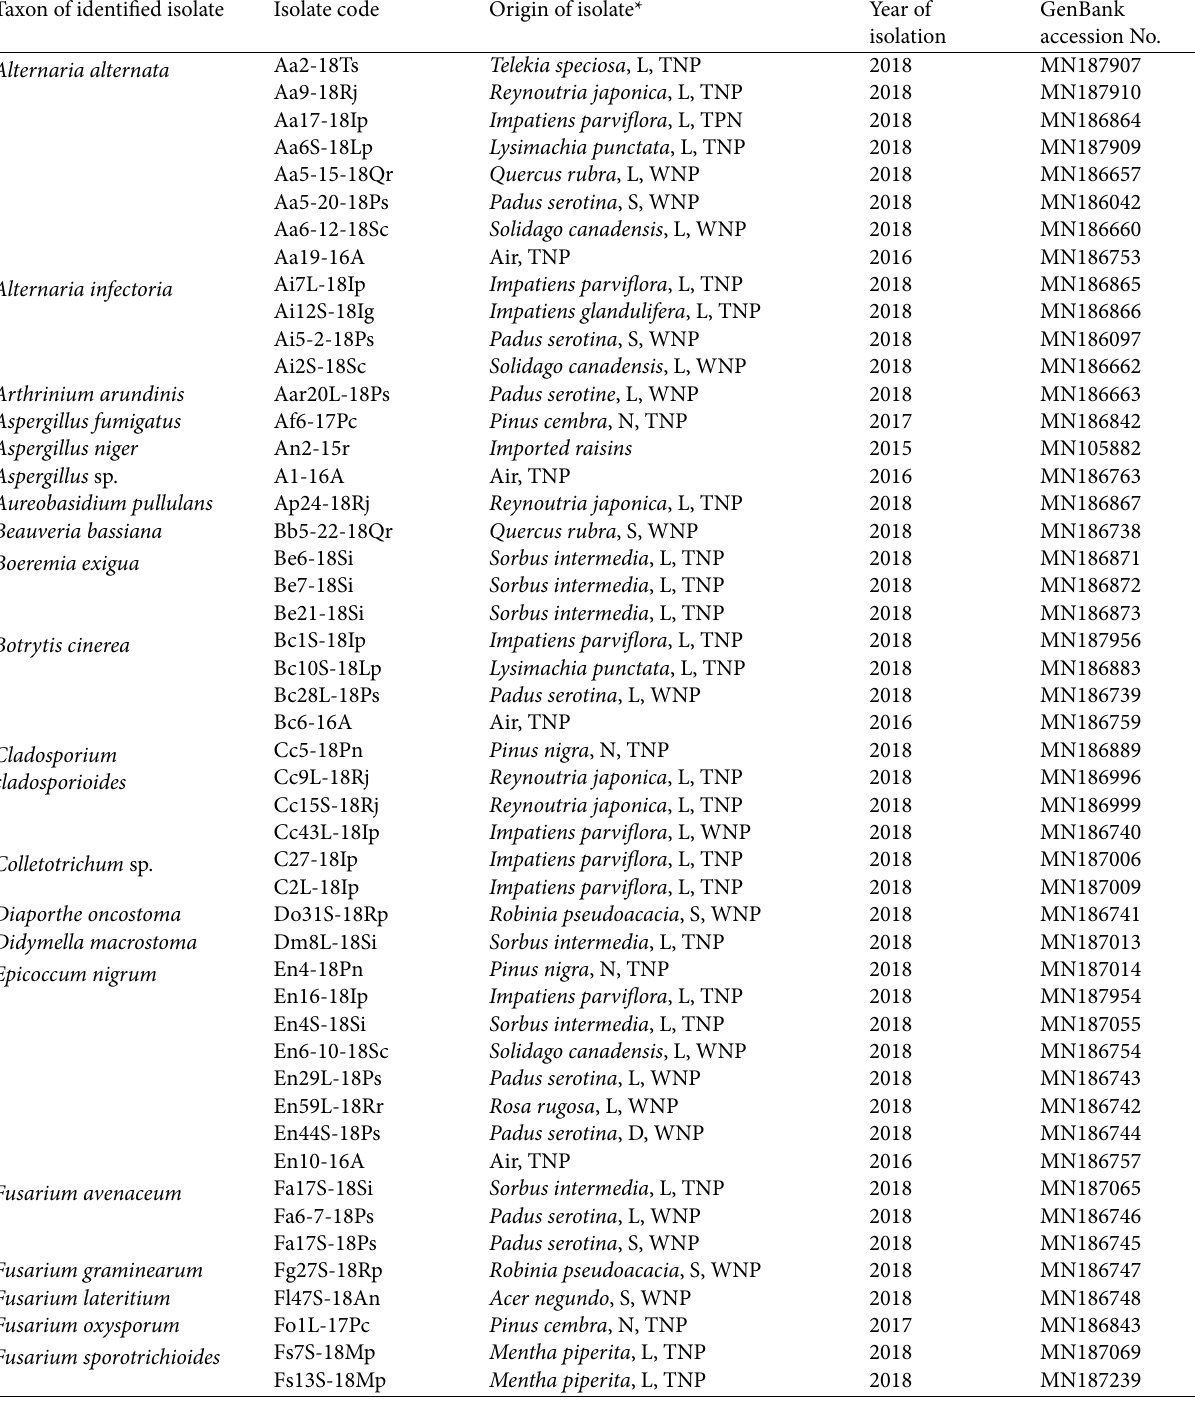
Table 1 Isolates of Ascomycota analyzed on the basis ofthe ITS region sequences. Taxon of identified